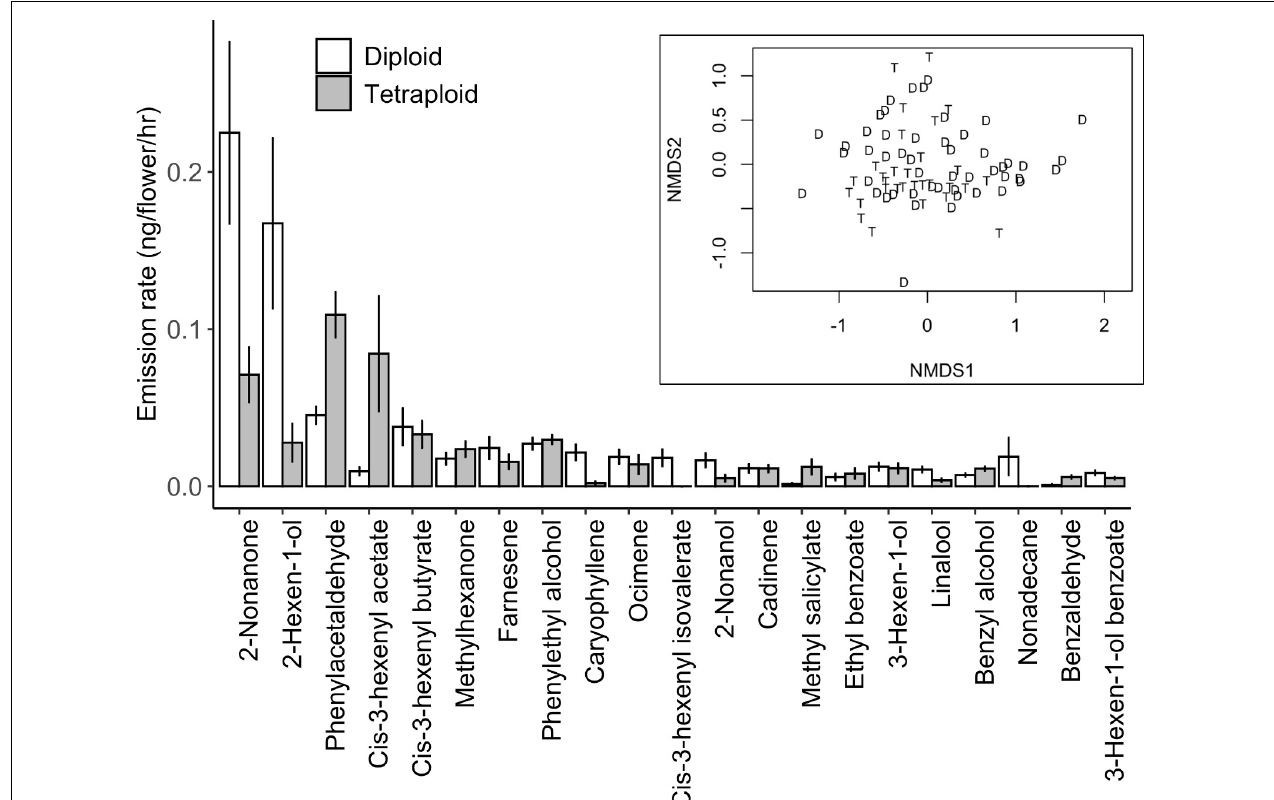
FIGURE 3 | Floral volatile compound mean emission rate ( + / − SE) from diploid and tetraploid Chamerion angustifolium . Compounds are ordered by their contributions to differences between diploids (white bars) and tetraploids (grey bars) based on SIMPER ( Supplementary Table 1 ). Inset: Overlap of floral scent bouquets for diploids (D) and tetraploids (T) based on all compounds